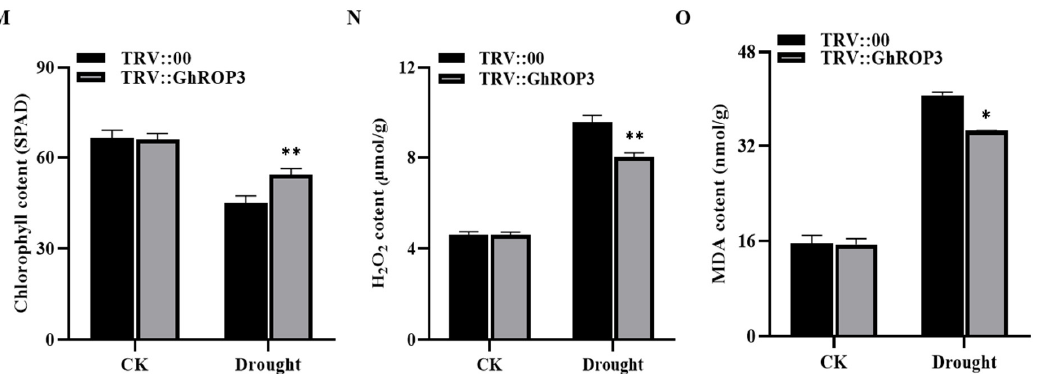
Figure 4. Cotton plants in which the GhROP3 gene was silenced were more sensitive to drought stress compared with negative control plants. ( A ) TRV1 and TRV2:GhROP3 vector diagram. ( B ) Phenotype of silenced GhCLA1 in cotton. ( C , D ) Silencing efficiency test of GhCLA1 and GhROP3 . ( E ) Phenotypes of GhROP3 -silenced and negative control plants before and after drought stress and after rehydration. ( F ) Survival rate of the negative control plants and GhROP3 -silenced plants after rewatering. Determination of drought-related biochemical indexes, including water loss rate (WLR) ( G ), relative water content (RWC) ( H ), proline (Pro) ( I ), catalase (CAT) ( J ), peroxidase (POD) ( K ), superoxide dismutase (SOD) ( L ), chlorophyll (Chl) ( M ), hydrogen peroxide (H 2 O 2 ) ( N ), and malondialdehyde (MDA) ( O ). Statistical analyses were performed using the Student t test. Asterisks indicate a significant difference compared with the control. *, p < 0.05; **, p < 0.01. In addition, we measured several physiological indicators, including WLR;